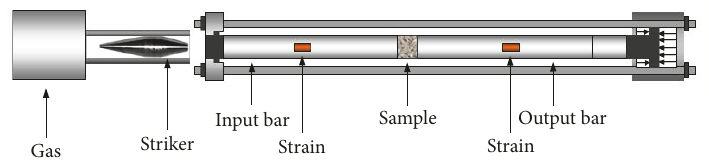
Figure 1: The Split-Hopkinson Pressure Bar test.